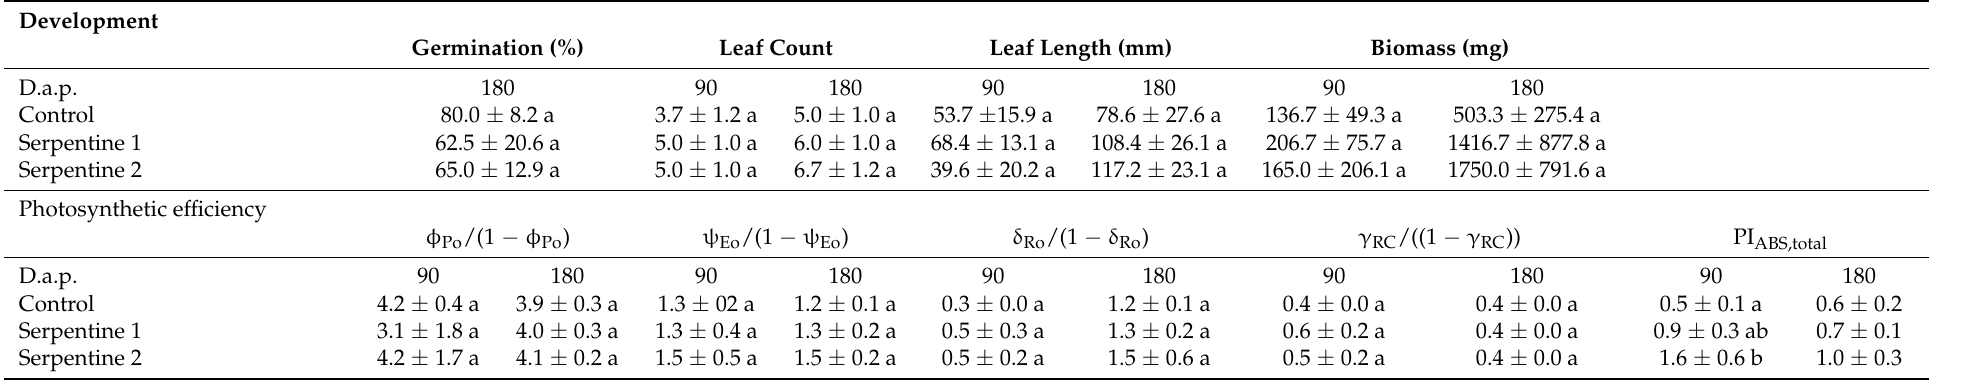
Table 2. Values (means ± std) of developmental and photosynthetic variables assessed in plants of B. radula under the study treatments. Different letters in the same column indicate significant differences among